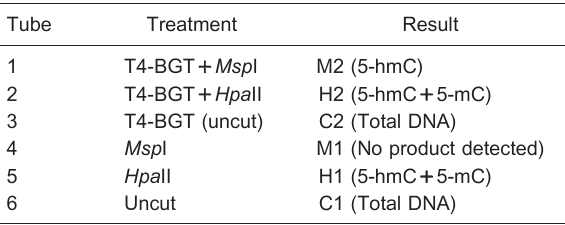
Table 1. Method I: treatments and quantification.